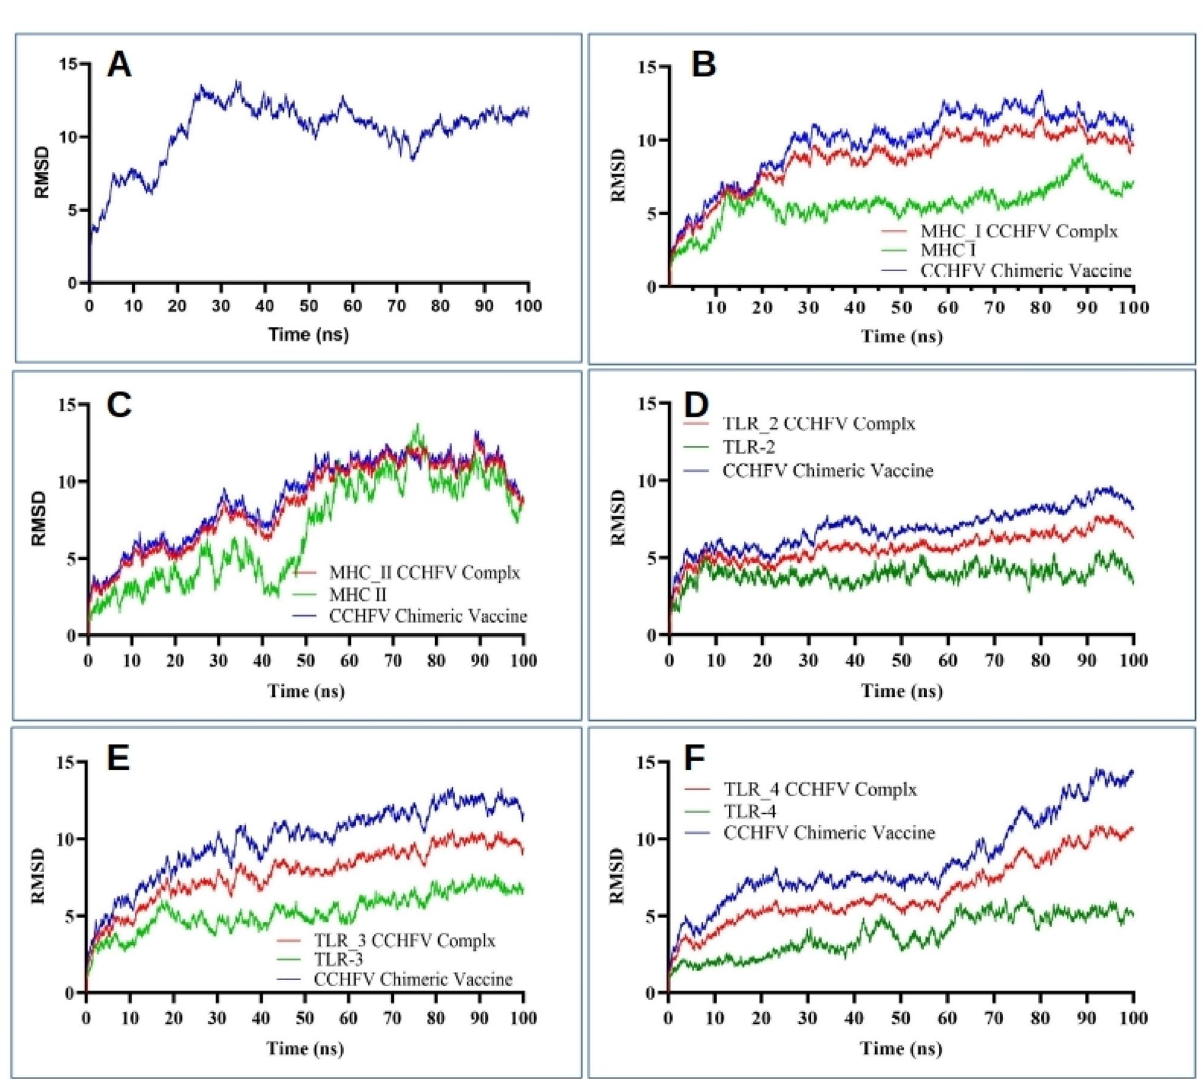
Figure 6. RMSD plot for 100 ns simulation production of ( A ) 3D model CCHFV chimeric vaccine, ( B ) MHC-1 in complex with the chimeric vaccine, ( C ) MHC-II in complex with the chimeric vaccine, ( D ) TLR-2 chimeric vaccine complex, ( E ) TLR-3 chimeric vaccine complex and ( F ) TLR-4 in complex with chimeric